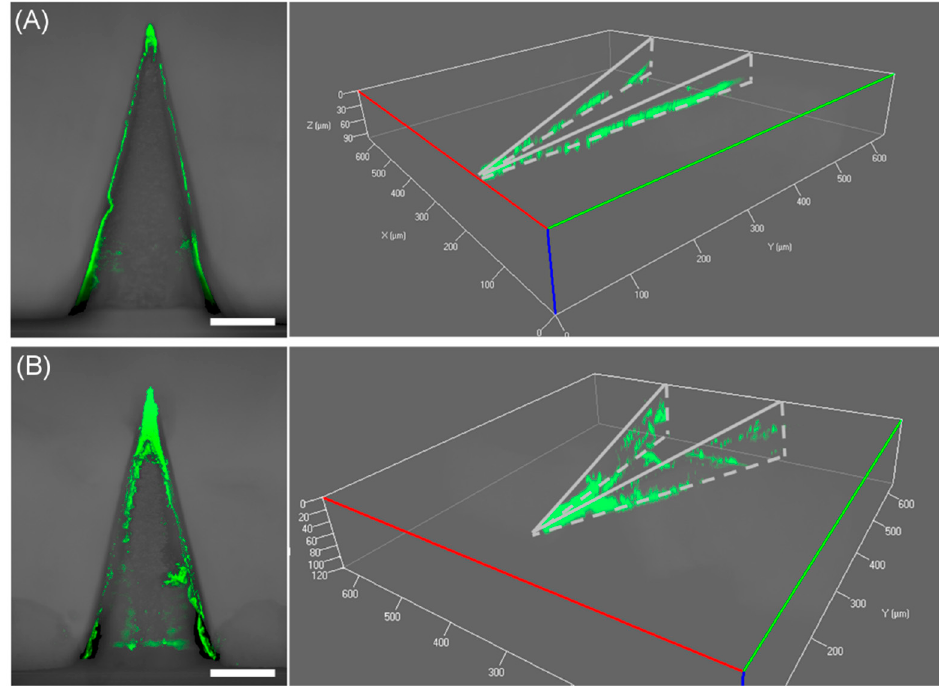
Figure 7. Reconstructed z-stack confocal microscopy images of ( A ) one blank layer and ( B ) three blank layers in the mold, showing the deposition profiles. Scale bars represent 100 µm.